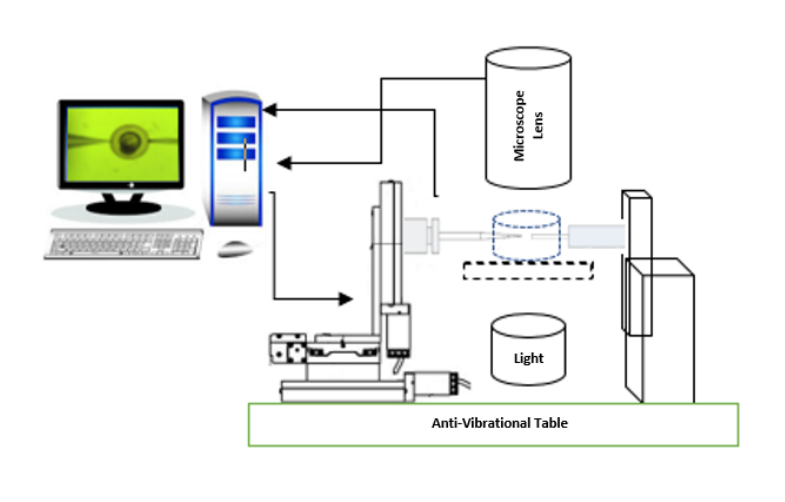
Figure 1. Schematic view of the experimental set up.